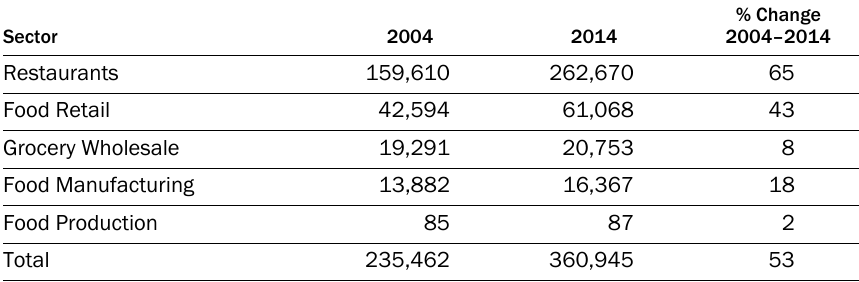
Table 1. Changes in Employment in New York City’s Food Sector,